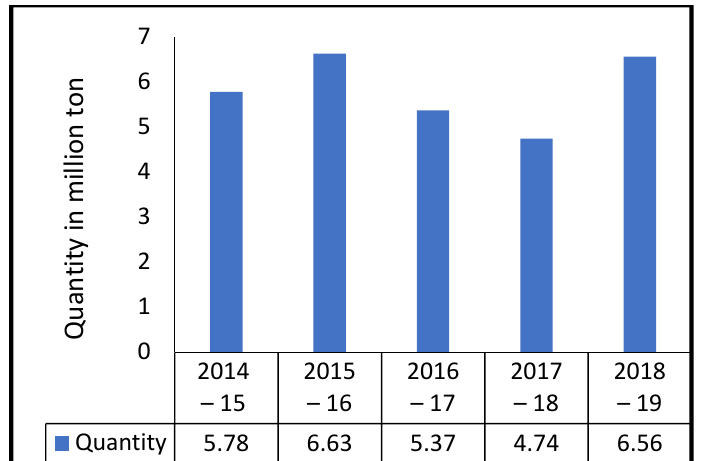
Figure 5. Steel scrap import over the years(Graph plotted using data from: Ministry of Steel ).